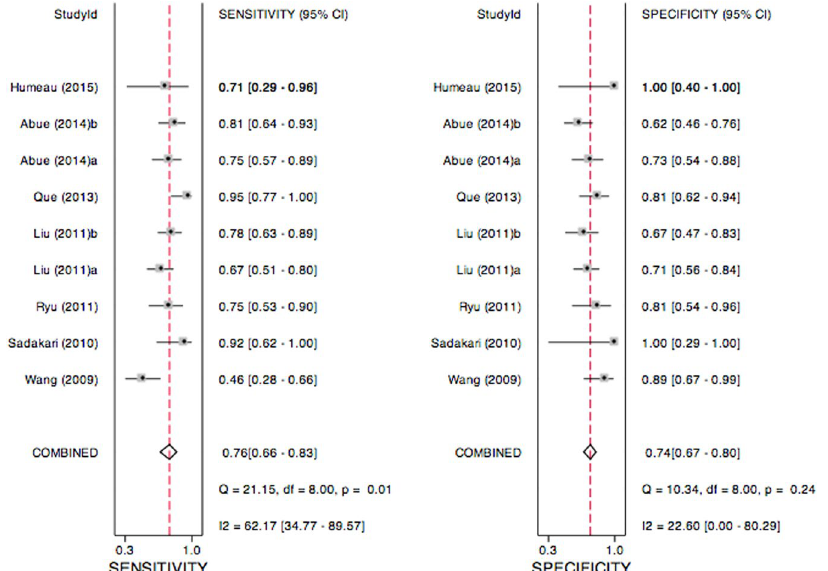
Figure 6. Forest plots showing the sensitivity and specificity of circulating hsa-miR-21-5p in the diagnosis of PC. ( A ) Forest plot showing the sensitivity of circulating hsa-miR-21-5p in the diagnosis of PC. ( B ) Forest plot showing the specificity of circulating hsa-miR-21-5p in the diagnosis of PC. 95% CI: 95% of confidence interval; PC: pancreatic